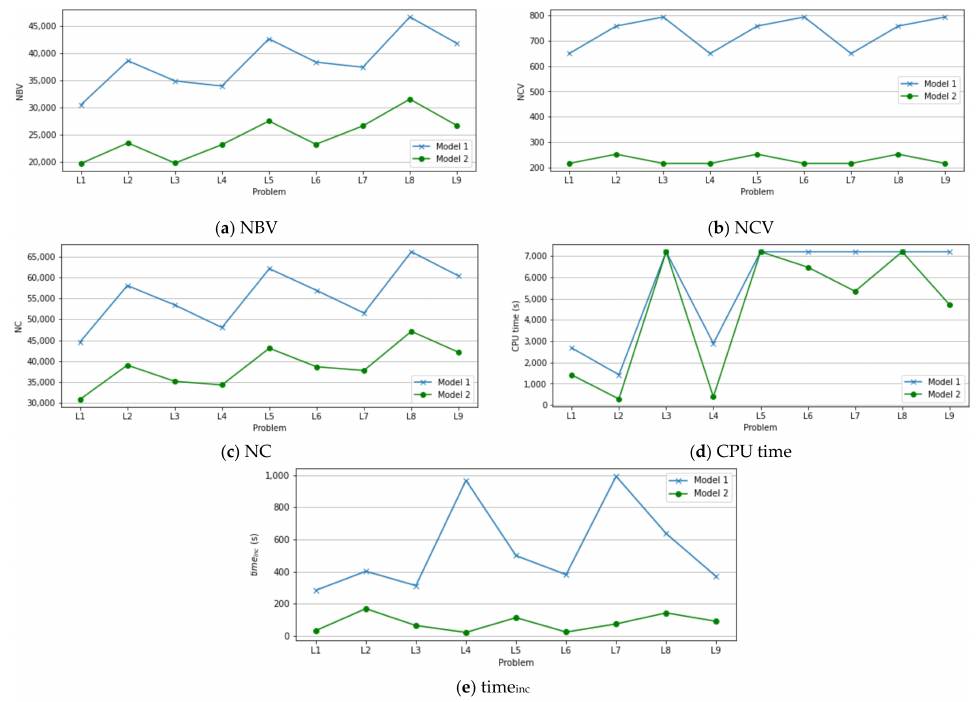
Figure 5. Comparison of the model size, as the ( a ) NBV (number of binary variables), ( b ) NCV (number of continuous variables), and ( c ) NC (number of constraints) and the ( d ) CPU time and ( e ) time inc (computational time to reach the incumbent solution) for solving the large problems between Model 1 and Model